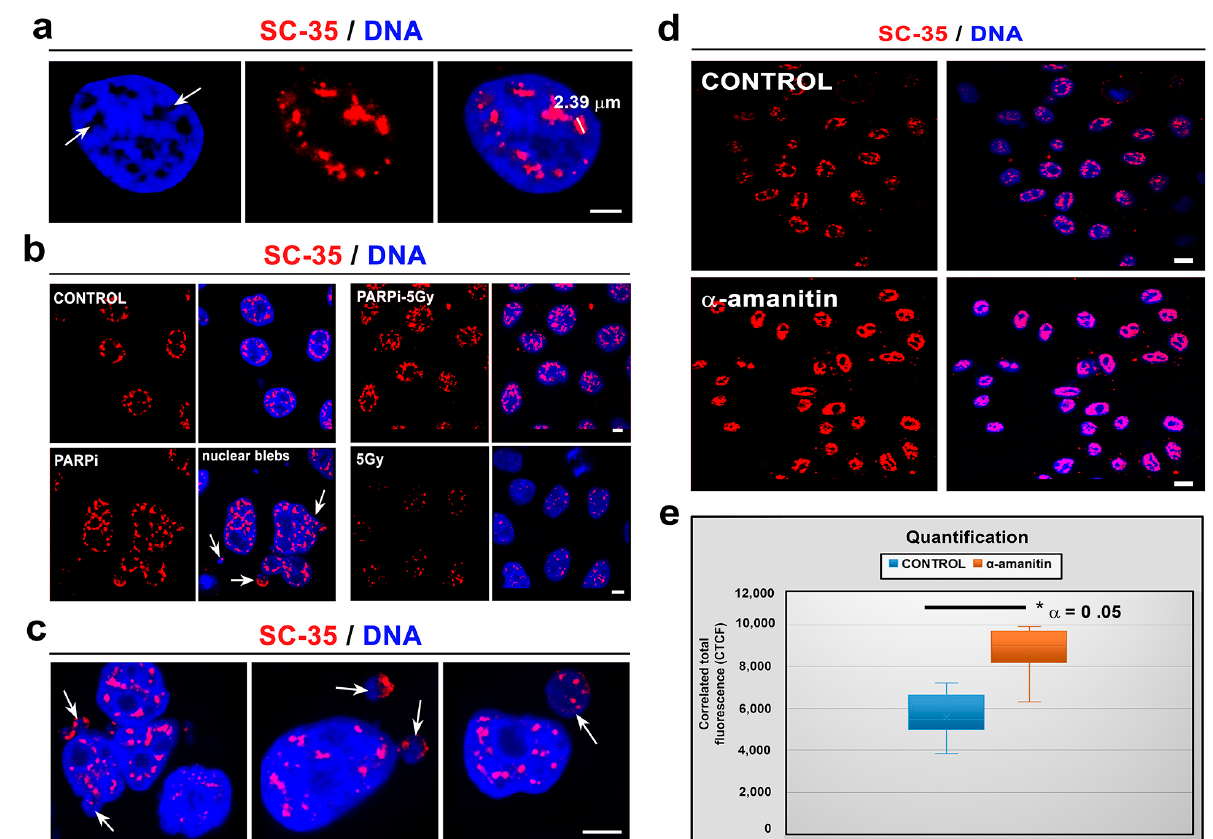
Figure 2. The localization of SC-35 in HeLa cells treated with potential DNA damaging agents like poly (ADP-ribose) polymerase (PARP) inhibitor, RNA pol inhibitors, and γ -radiation. ( a ) SC-35 occupies interchromatin space. DAPI was used for visualization of the low density of chromatin. The selected nuclear speckle diameter was 2.38 μ m; the volume of nuclear speckles was 4.79 ± 0.78 μ m 3 . ( b ) Nuclear distribution of SC-35 in non-treated HeLa cells, and cells treated with a PARP inhibitor, olaparib, and 5Gy of γ -rays. ( c ) A detail of nuclear blebs and micronuclei, positive on the SC-35 protein (red fluorescence signal). Nuclear blebs and micronuclei mainly appeared after the cell treatment by PARP inhibitor, olaparib. White arrows show nuclear blebs and micronuclei. ( d ) Nuclear distribution of SC-35 in non-treated HeLa cells and cells treated with RNA pol II inhibitor, α -amanitin. Bars indicate 10 μ m in panels a – d . ( e ) The chart shows the corrected total fluorescence value (CTCF) for each cell analyzed using ImageJ software; the following formula was used: CTCF = integrated density (area of selected cells x mean fluorescence of background readings). A total number of fifty cells were used for analysis. Quantification was done in non-over saturated images; for image presentation and printing, the saturation was increased. The non-parametric Mann–Whitney test was used for statistical analysis. Significance is shown for α = 0.05.